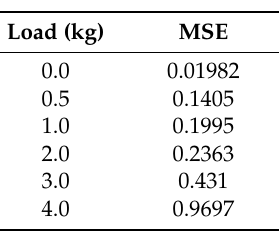
Table 7. The MSE of the 20 cm contraction PMA at different loads.